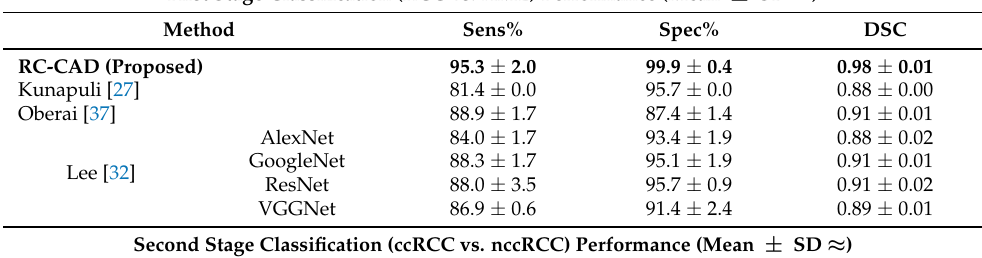
Table 6. Diagnostic performance comparison for both classification stages between the developed RC-CAD system and the state-of-the-art approaches by [27,32,37]. The diagnostic abilities of the RC-CAD outperformed all other methods in both classification stages. Let Sens: sensitivity, Spec: Specificity, DSC: Dice similarity coefficient, and Acc: